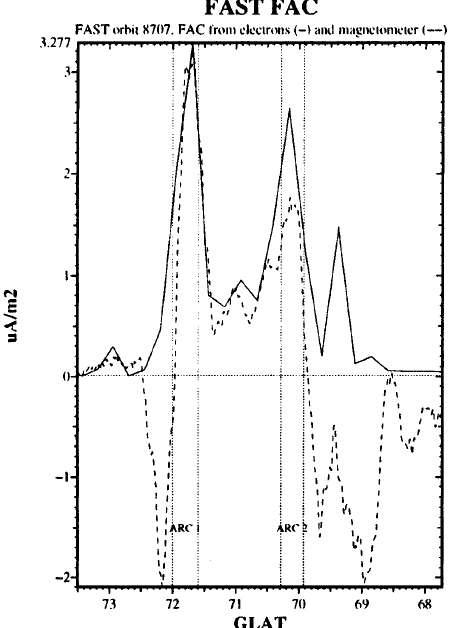
Fig. 3. FACs determined from FAST magnetic field and particle data plotted versus geographic latitude. Positive FAC is upward. The solid line represents the FAC computed from the electron data while the dashed line is the FAC estimated from the satellite magnetometer data